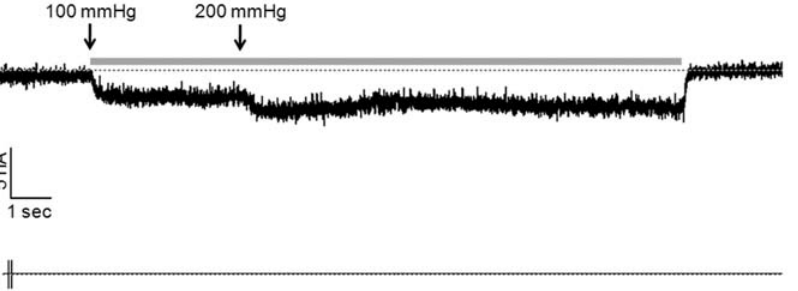
Figure 9. MCs transduce the strength and the length of the stimulation. A 100 mmHg-suction was applied to transfected MCs. Stimulation induced inward currents sustained throughout the stimulation (about 15 sec). An increase in the strength of the stimulation after 4 sec led to increased inward currents.